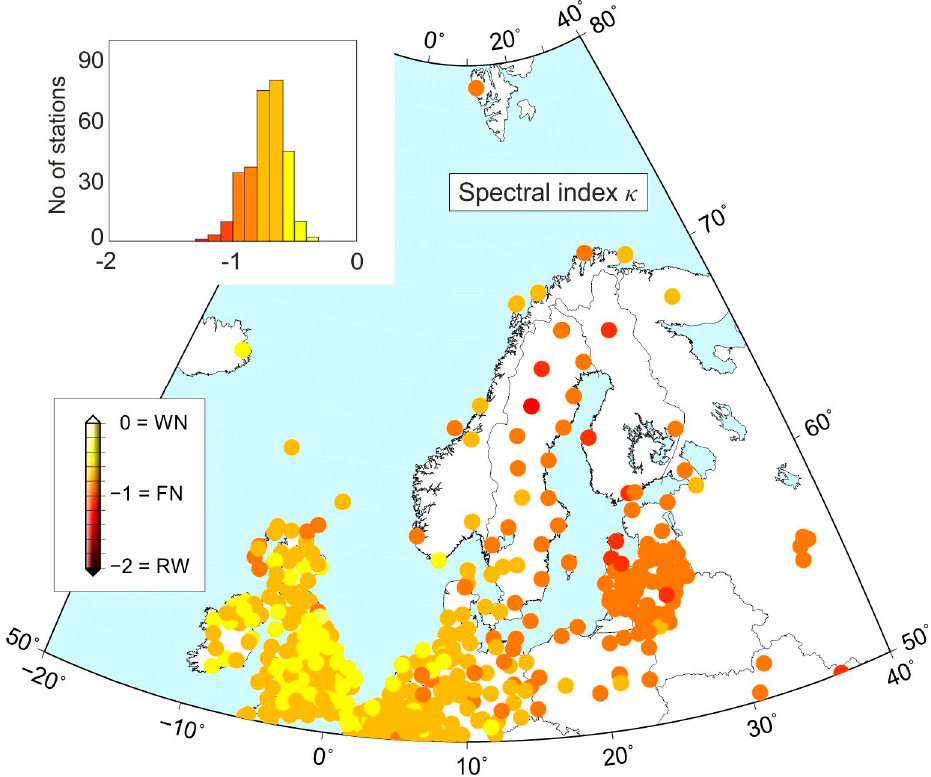
Figure 5. The spectral indices of the 469 European GPS position time series. The special cases of white noise (WN), flicker noise (FN) and random-walk noise (RW) are marked on the legend.